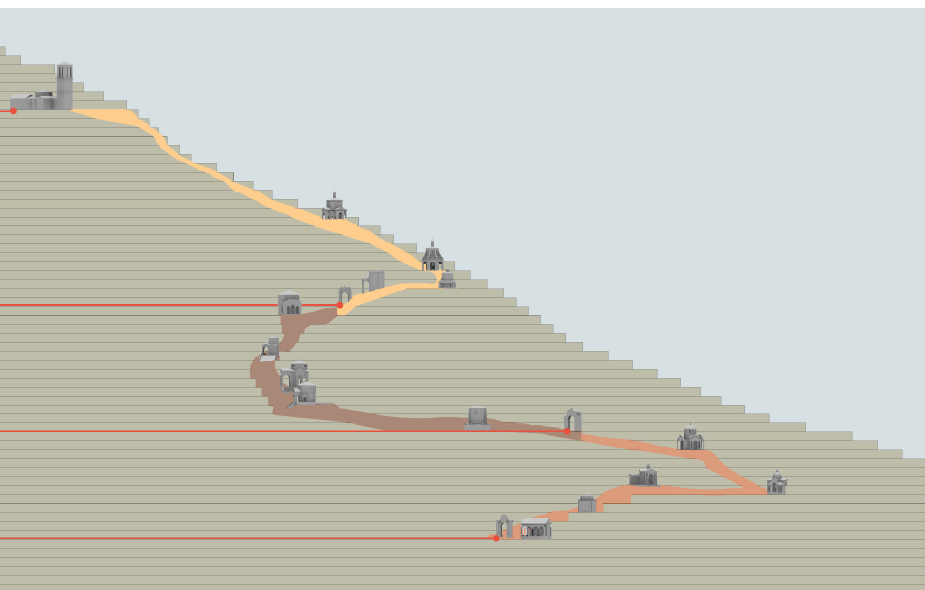
Fig. 2 Front view of chapels and the devotional path with the main altitude